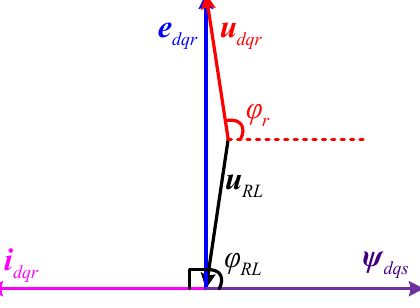
Figure 3. Rotor port vector diagram.